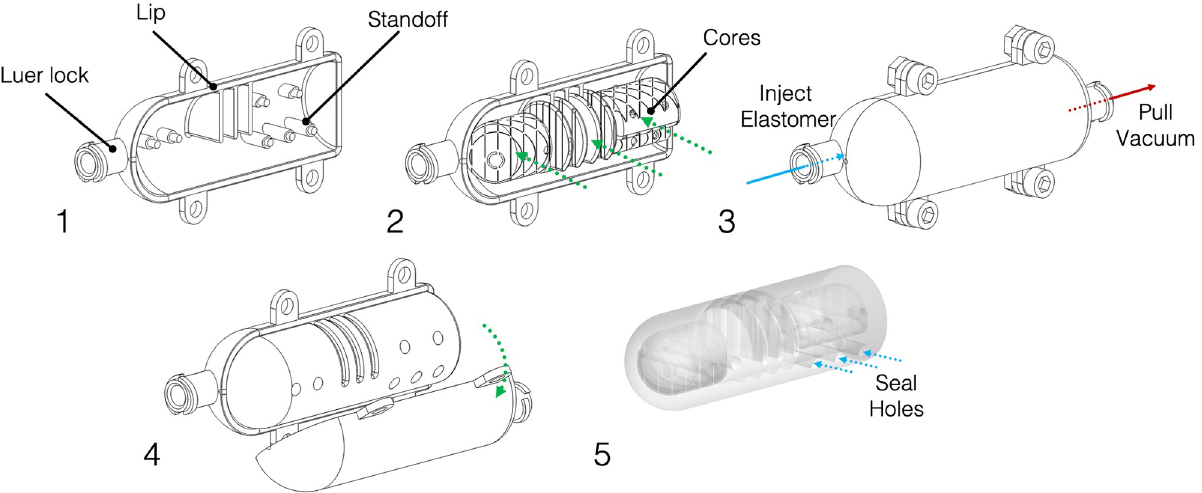
Fig 4. General fabrication steps for negshell casting. 1: The mold is prepared. The Luer lock, lip and standoff features are highlighted. 2: The cores are inserted into one side of the mold. 3: The mold is clamped shut with fasteners and elastomer is injected via a syringe. Another syringe can be used at the other end to pull a vacuum to help with liquid elastomer flow. 4: Once the elastomer has set, the mold haves can be removed. 5: The completed soft robot component.